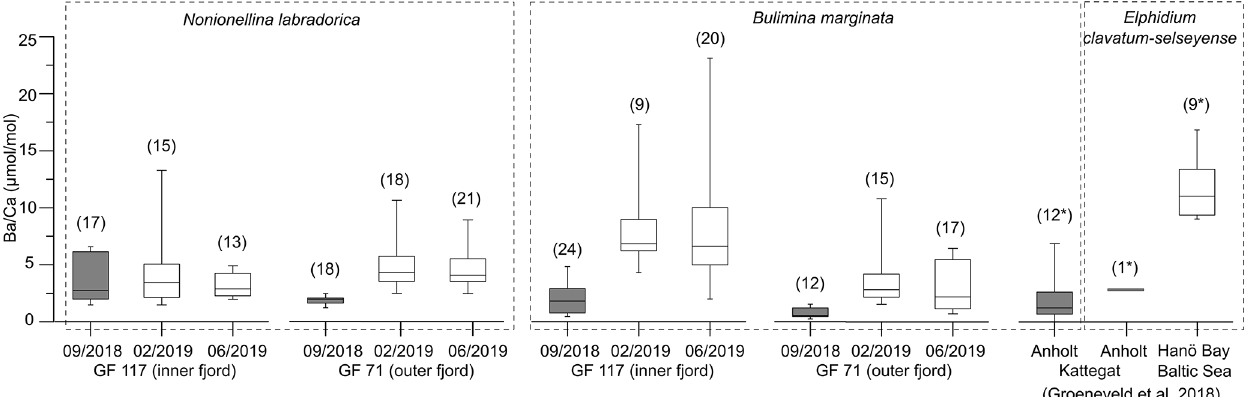
Figure 3. Box and whisker plots of benthic foraminiferal Ba / Ca from Gullmar Fjord (this study), Anholt (Kattegat) and Hanö Bay (Baltic Sea) (Groeneveld et al., 2018). Grey boxes represent samples from conditions without direct influence of terrestrial Ba addition, white boxes terrestrial-influenced samples. Number of analyzed specimens (for LA ICP-MS analyses) or bulk samples (of > 8 specimens each, ICP-OES analyses, marked by ∗ ) given in brackets. Note that Ba / Ca is derived from different species (marked by dashed